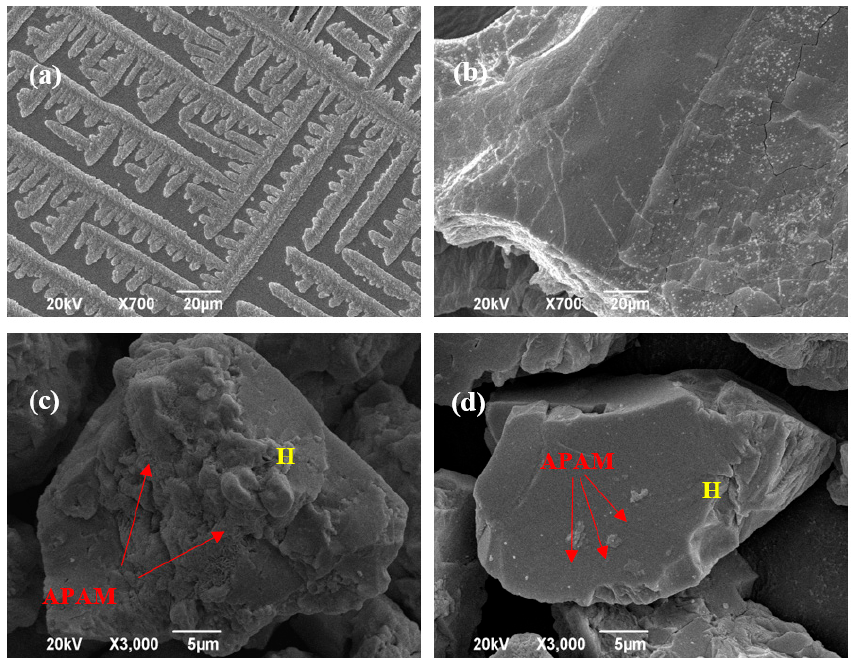
Figure 8. SEM images of ( a ) APAM, ( b ) APAM treated with Fe 3+ , ( c ) hematite treated with APAM, and ( d ) hematite coated with APAM in the presence of Fe 3+ . H: hematite (20–30 μ m).